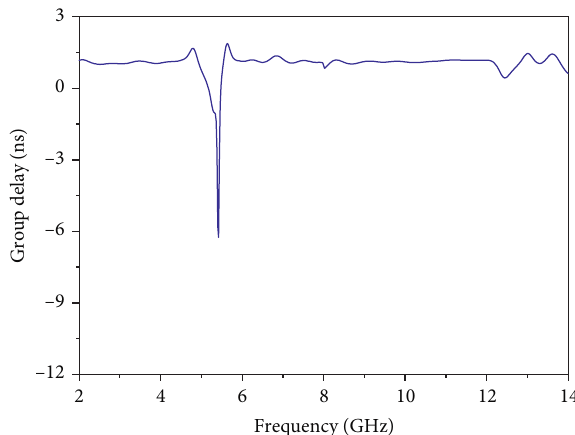
Figure 8: Group delay of the band-notched UWB antenna.